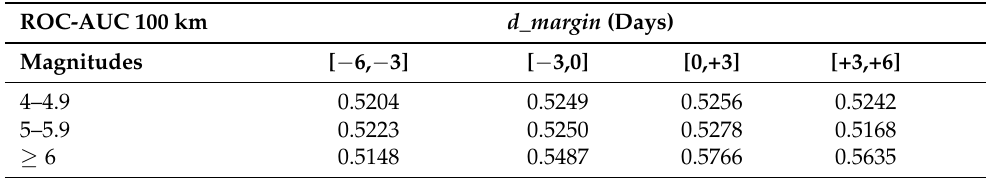
Table 5. ROC-AUC values for radius = 100 km .